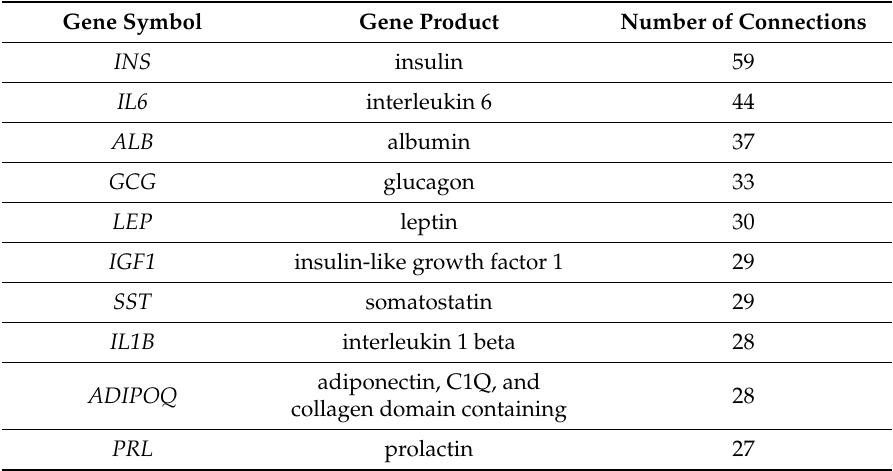
Table 1. The genes demonstrating the largest number of connections in the gene network of hypoglycemia and hyperglycemia. Gene Symbol Gene Product Number of Connections